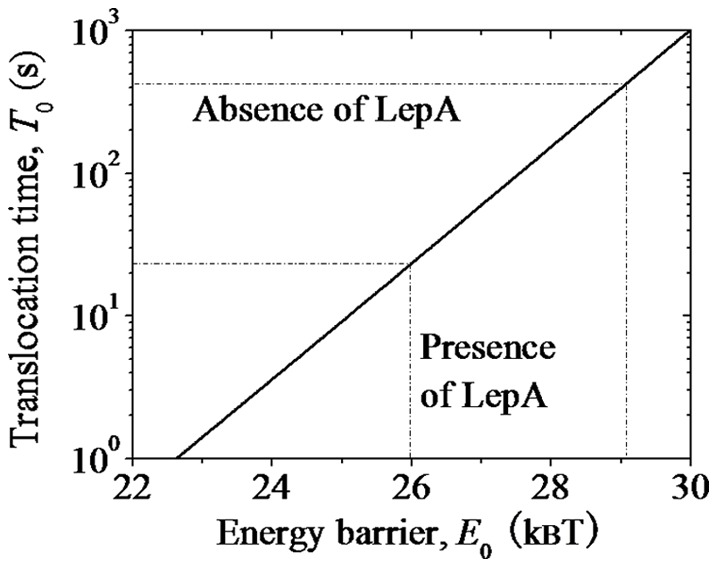
Results of backward mRNA translocation time T
0 as a function of energy barrier E
0, which are calculated by Eq. (3) but with ENR and EH being replaced by E
0 and EPOST, respectively. EPOST = 33.91kBT.